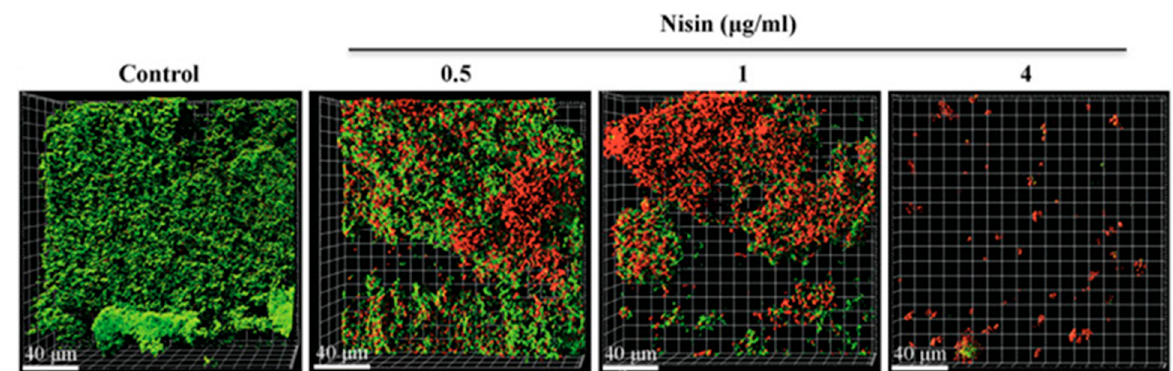
Figure 14. Confocal microscopy images of the influence of nisin concentration on oral biofilm formation under the controlled microfluidic model system. A green signal indicates viable live cells (Syto 9) and a red signal indicates damaged/dead cells (propidium iodide). No biofilm was observed at a nisin concentration of 4 μ g/mL (Reproduced with permission from [140], Meta UCL, 2015 ).